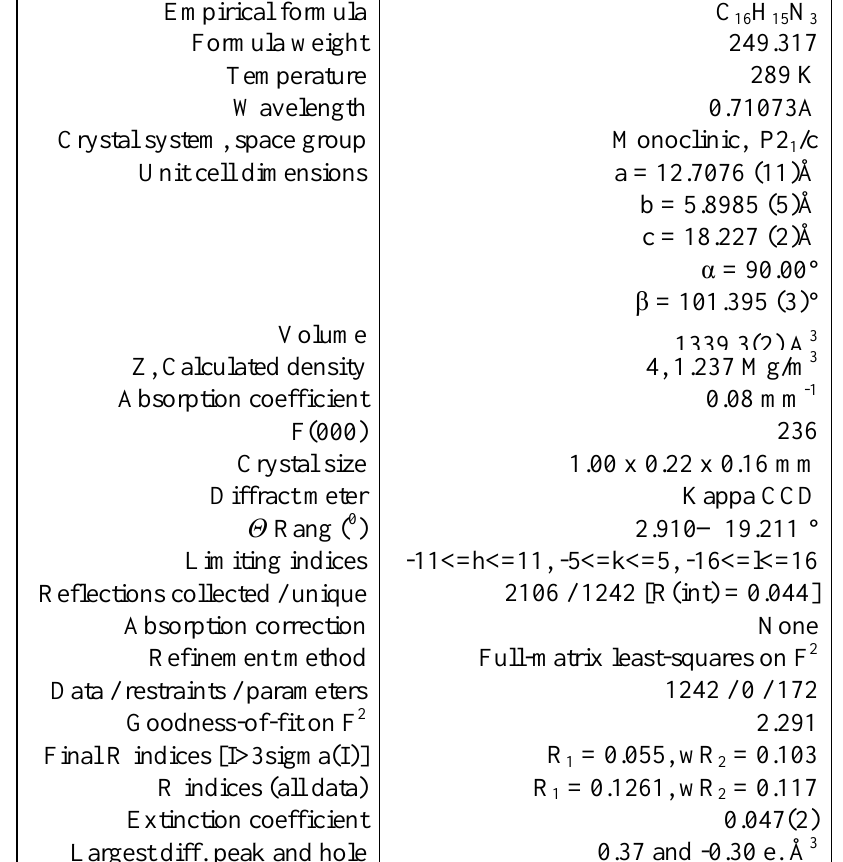
Table 1. Crystal data and structure refinement for compound